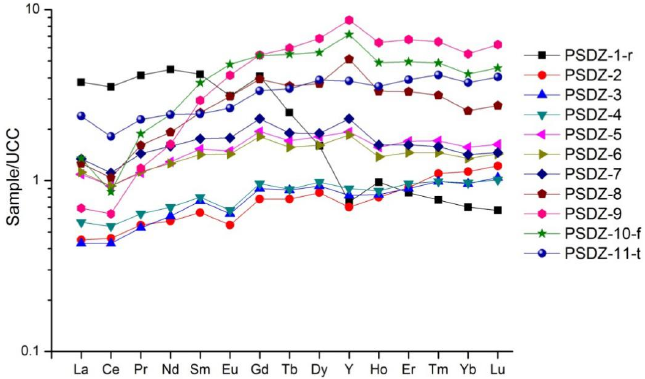
Figure 5. The REY distribution patterns of coal, roof and floor samples in the Donggou mine. The REY data of the upper continental crust (UCC) are cited from Taylor and Mclennan (1985) [52].